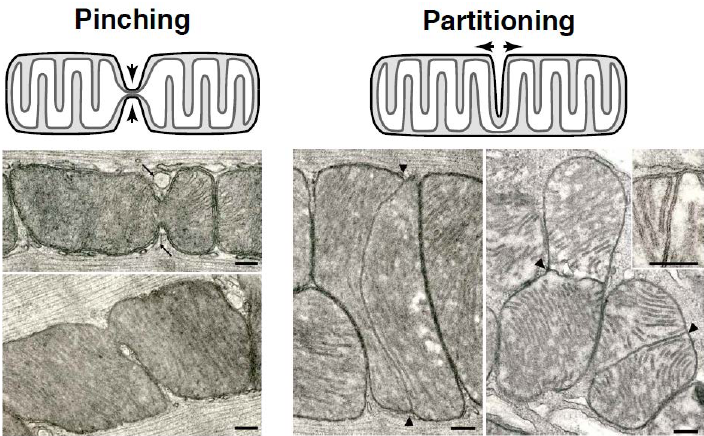
Figure 1. In skeletal muscle, mitochondrial division proceeds through alternative mechanisms termed pinching and partitioning. For pinching (left side), the outer membranes on opposite sides of a mitochondrion make deep invaginations at sites of ensuing fission. Adjacent sarcoplasmic reticulum membranes are highlighted (arrows). For partitioning (right side), elongated cristae span the width of the organelle and maintain direct continuity with the boundary membrane at either end. Subsequent in-growth of the outer membranes would then lead to mitochondrial fission. Scale bar = 0.2 µm.